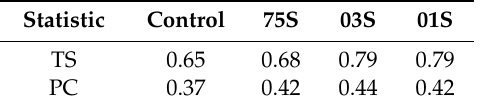
Table 4. Statistics of land use for the inner domain compared with AWS